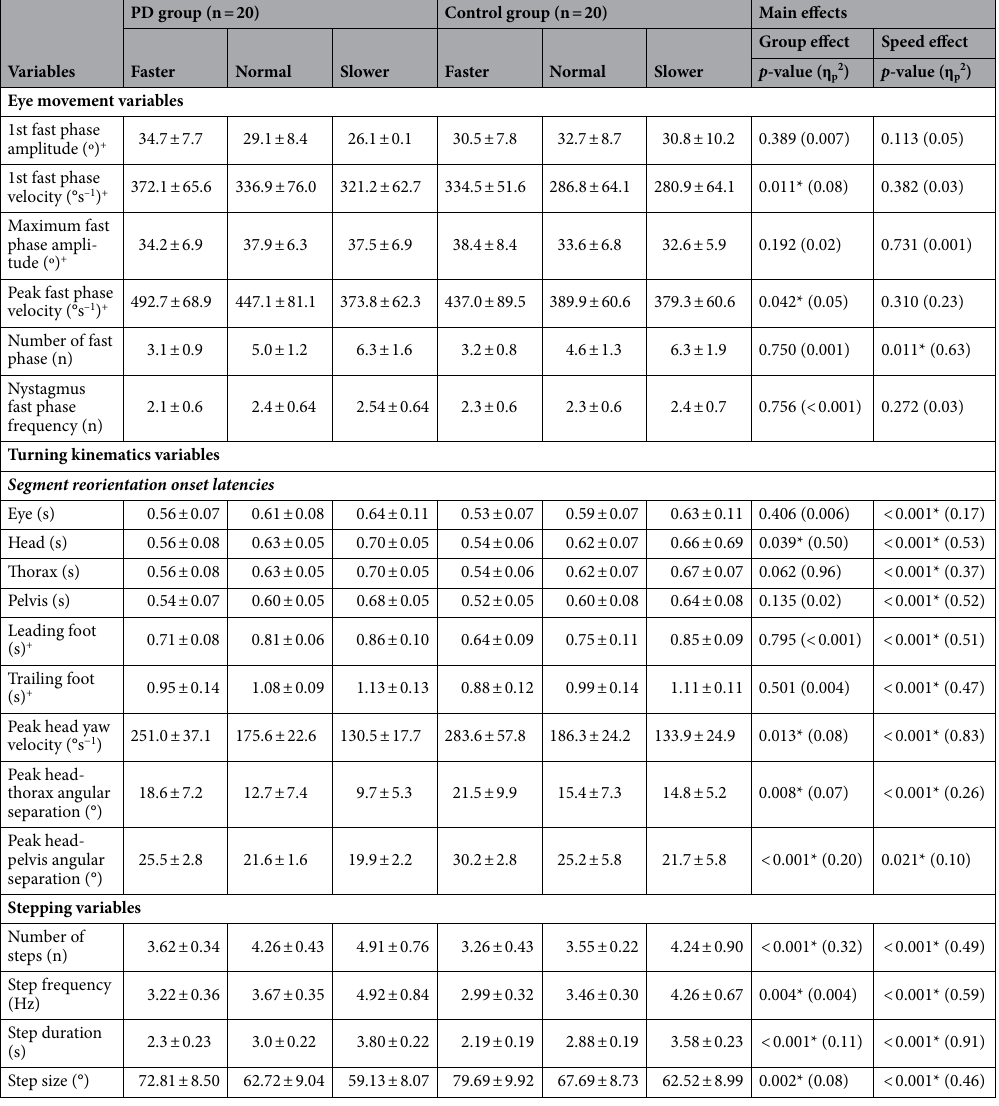
Table 2. The interaction between healthy age matched control and Parkinson’s disease (PD) groups and different speeds for turning characteristics variables shown as mean and standard deviations (SD), performed by mixed model analysis of variance. + Significant interaction ( p < 0.05) and *significant main effects ( p < 0.05) from mixed model analysis of